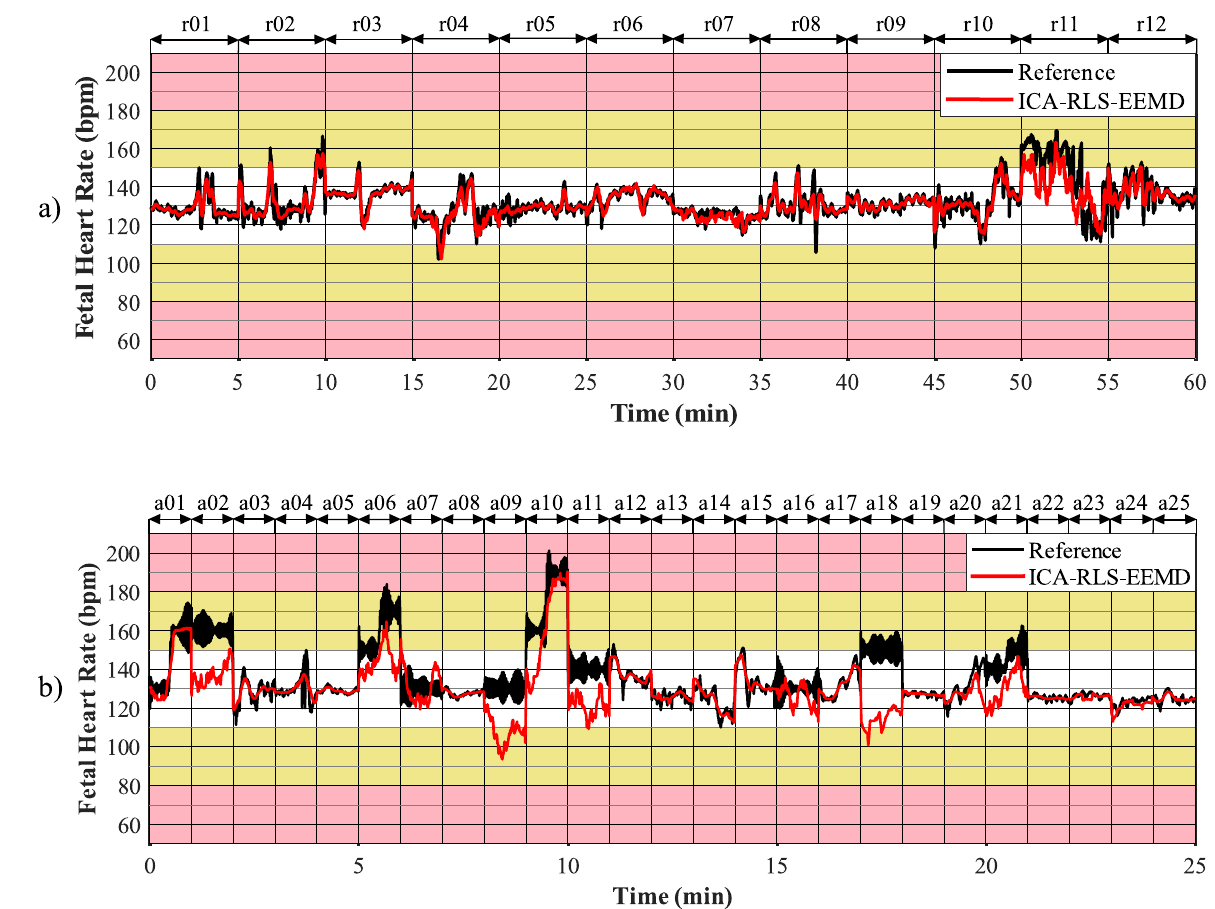
Fig 10. Comparison of fHR traces extracted using the ICA-RLS-EEMD method with annotation a) for all recordings from the FECGDARHA database and b) for 25 recordings from the Challenge database.